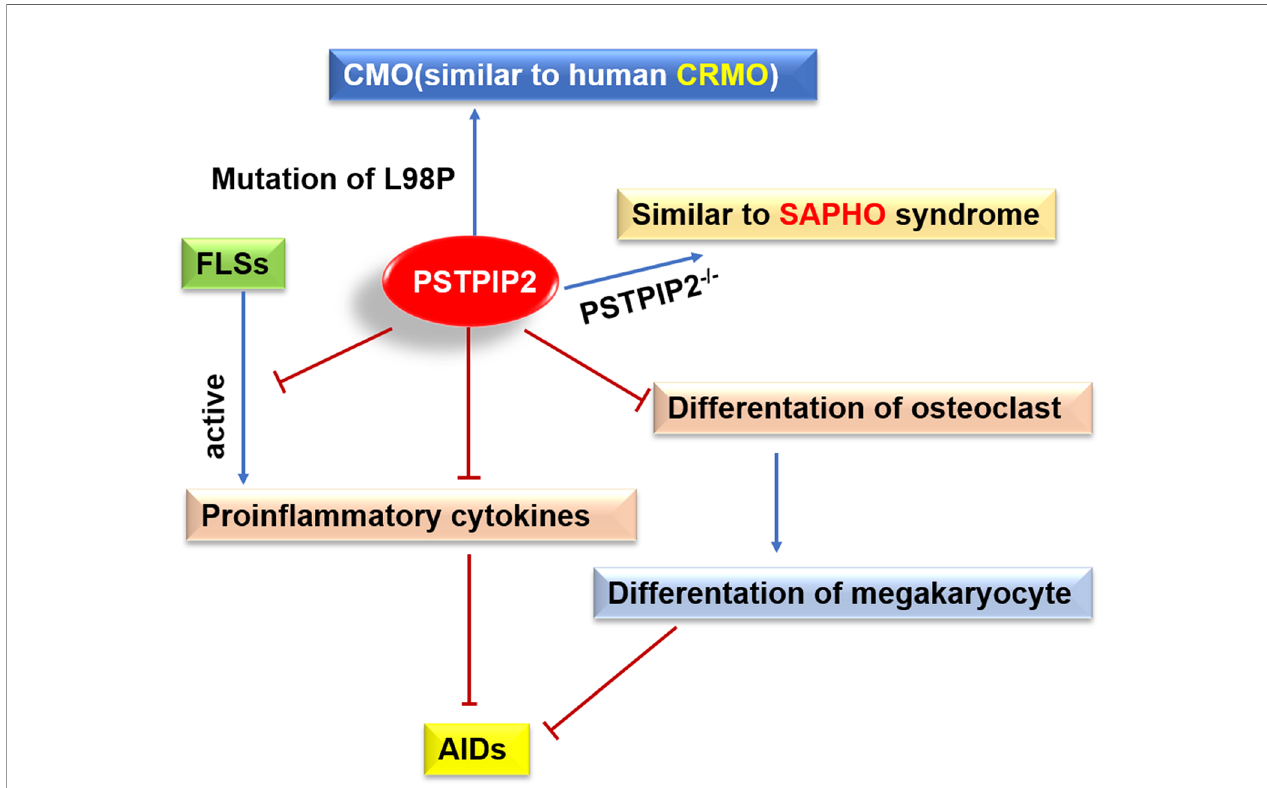
FIGURE 3 | Possible roles of PSTPIP2 in AIDs. Mutation of L98P in PSTPIP2 caused CMO that similar to human CRMO, and PSTPIP2 -/- mice exhibit an in fl ammatory response similar to SAPHO syndrome. PSTPIP2 can inhibit the activation of FLSs, the production of proin fl ammatory cytokines and the differentiation of osteoclasts, leading to hinder the occurrence of